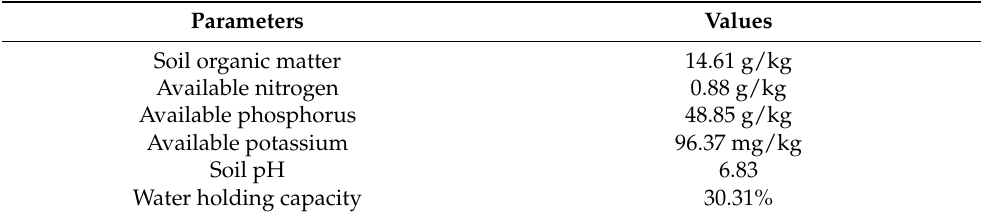
Table 1. Physical and chemical composition of the soil of the experimental pots. Parameters Values Soil organic matter 14.61 g/kg Available nitrogen 0.88 g/kg Available phosphorus 48.85 g/kg Available potassium 96.37 mg/kg Soil pH 6.83 Water holding capacity